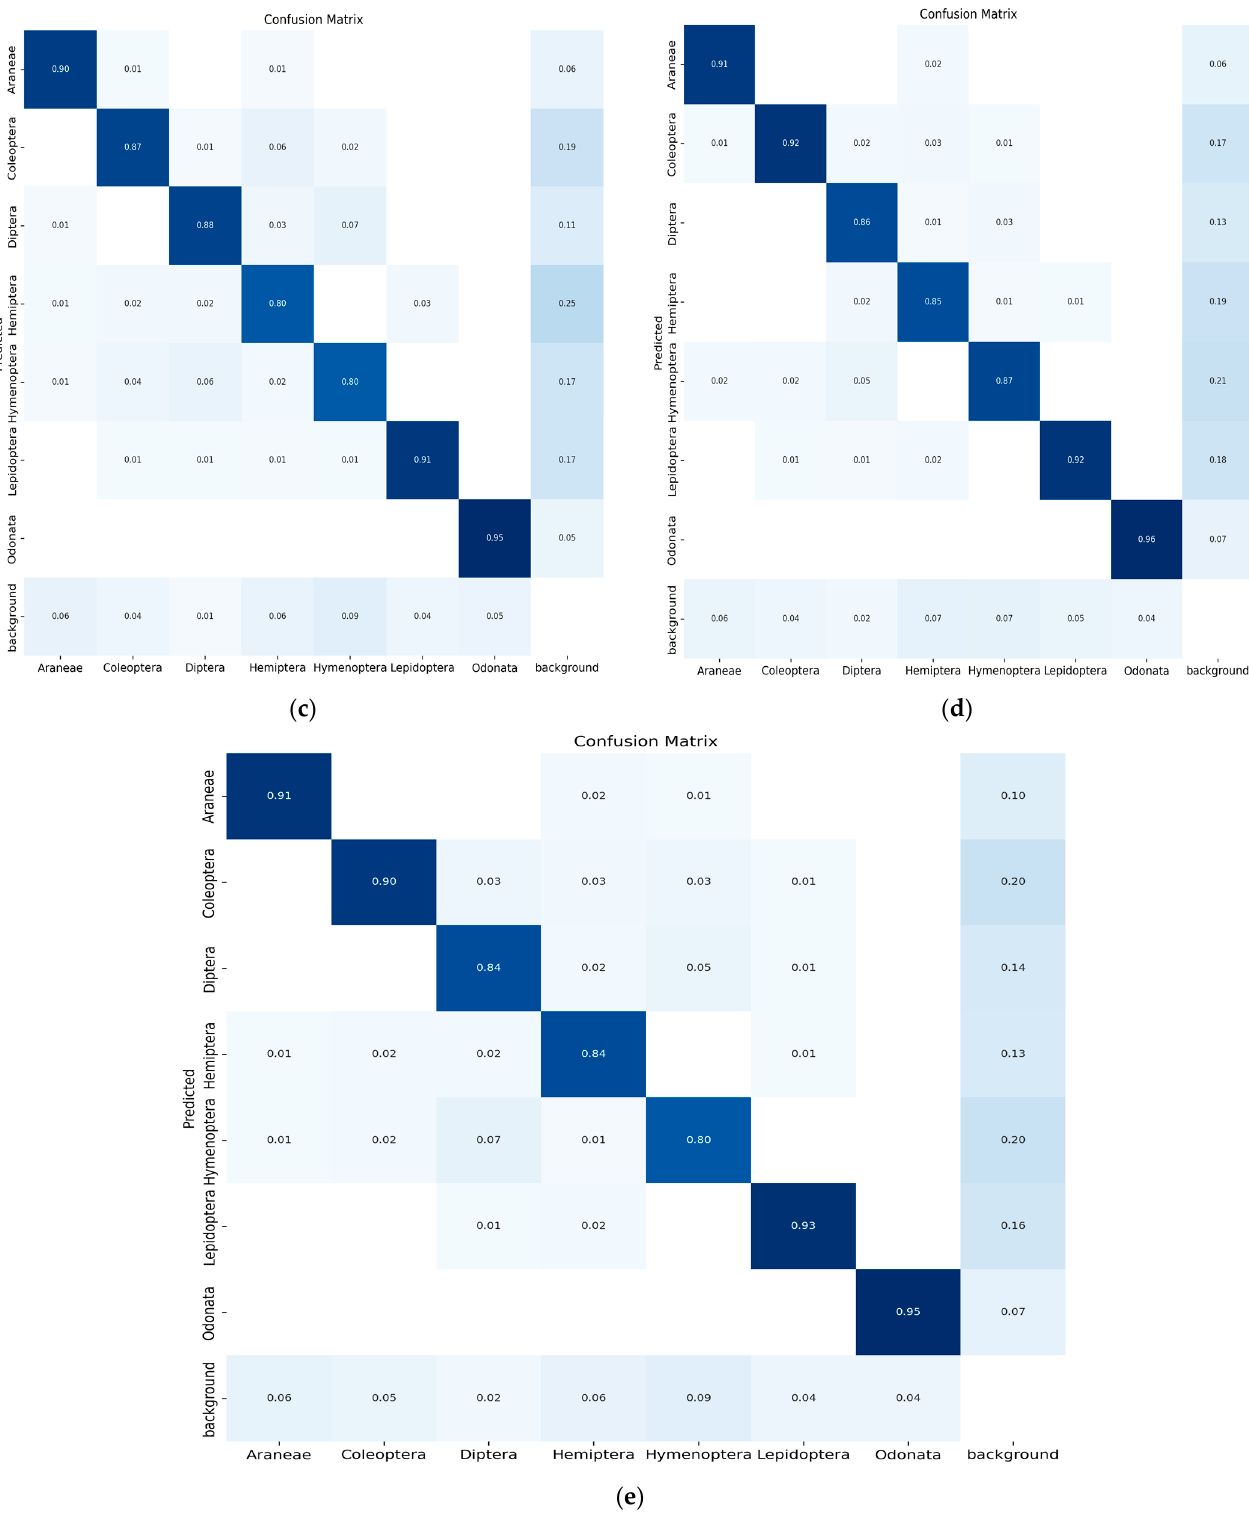
Figure 9. ( a ) Confusion matrix (YOLO-v5s), ( b ) confusion matrix (YOLO-v5m), ( c ) confusion matrix (YOLO-v5l), ( d ) confusion matrix (YOLO-v5x) and ( e ) confusion matrix (modi fi ed YOLO-v5x).